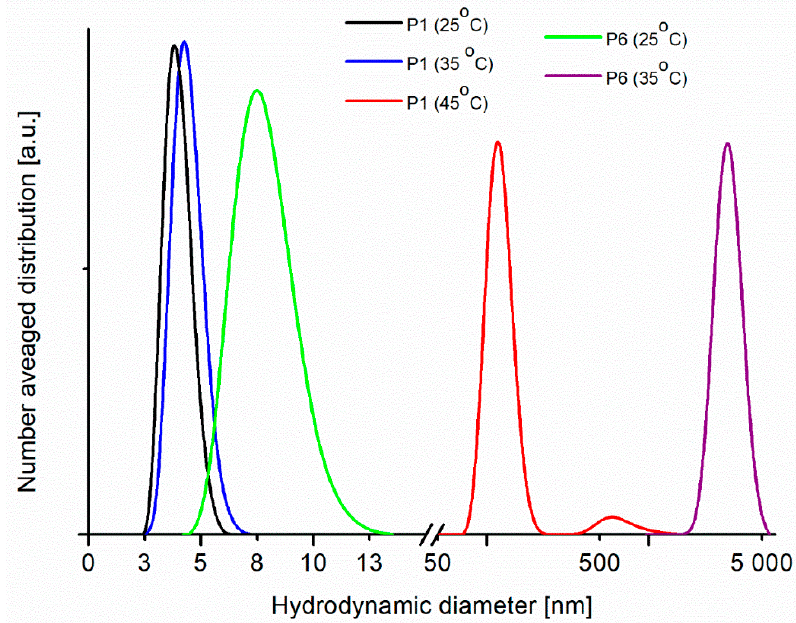
Figure 6. The number-averaged hydrodynamic diameter distributions in aqueous solutions of P1 and P6 at 25, 35 and 45 ◦ C from Dynamic Light Scattering (DLS) measurements.